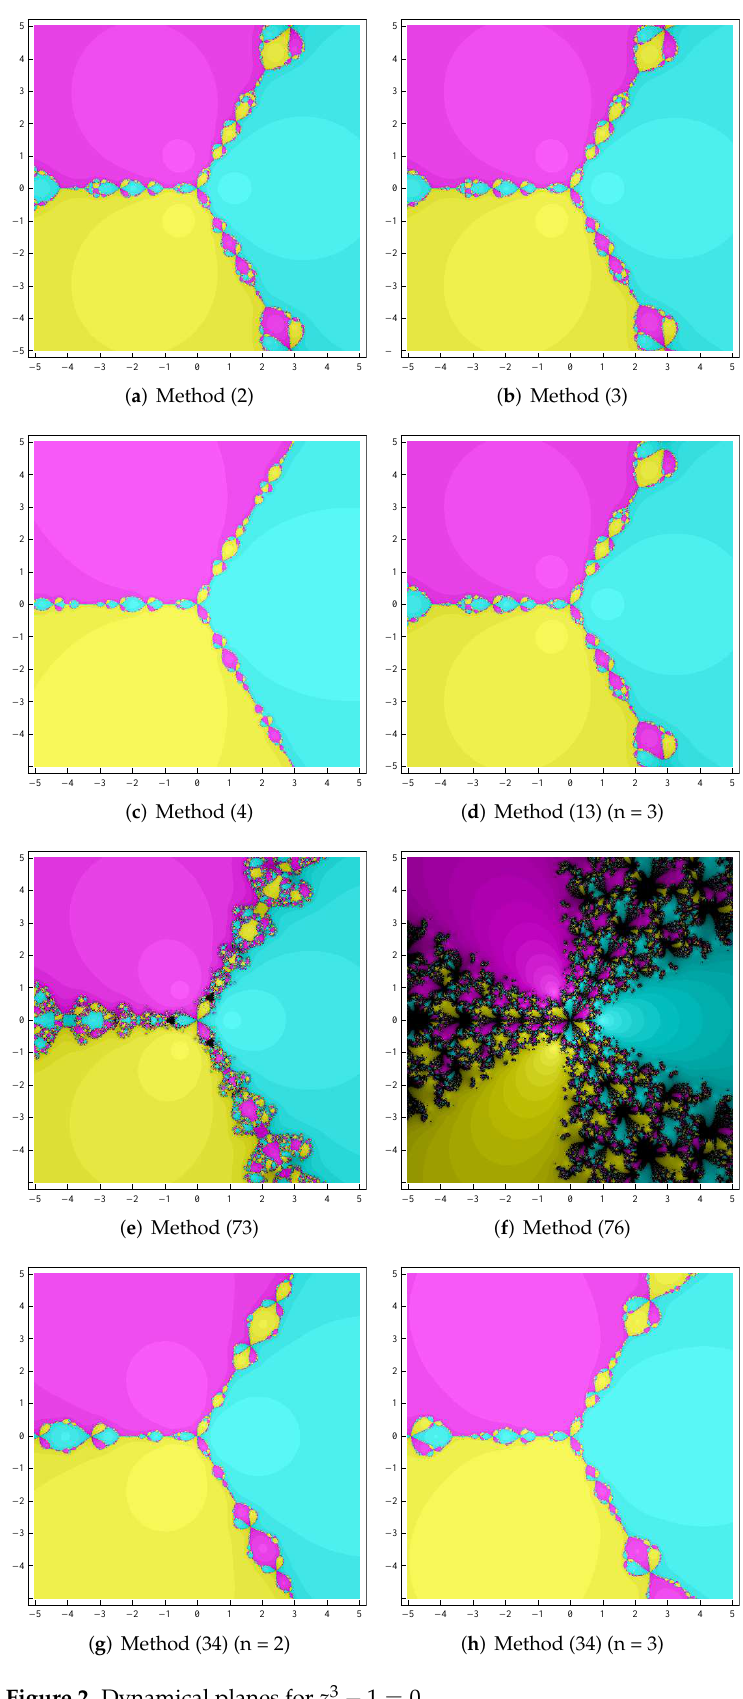
Figure 2. Dynamical planes for z 3 − 1 =